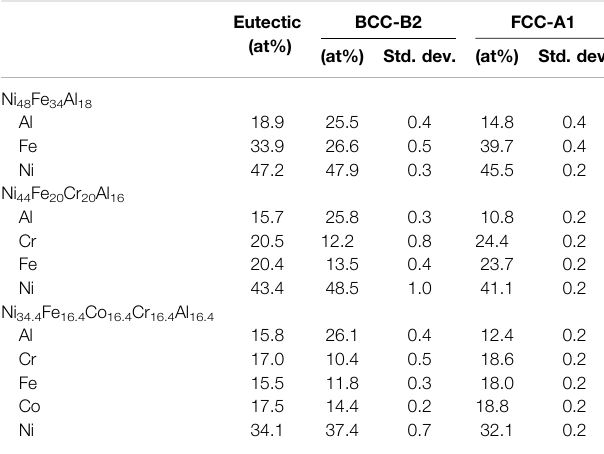
TABLE 3 | Quantitative energy dispersive spectroscopy-analysis of directionally solidi fi ed samples close to the solidi fi cation front. Eutectic BCC-B2 FCC-A1 (at%) (at%) Std. dev. (at%) Std.